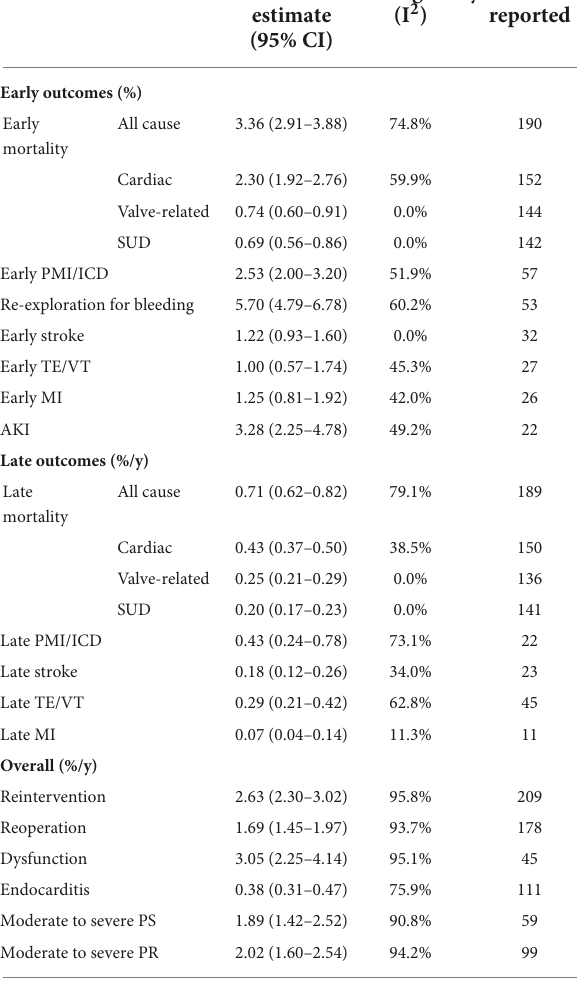
TABLE 2 Overall pooled outcomes. in both subgroups. TA accounted for 26.9% of cases in